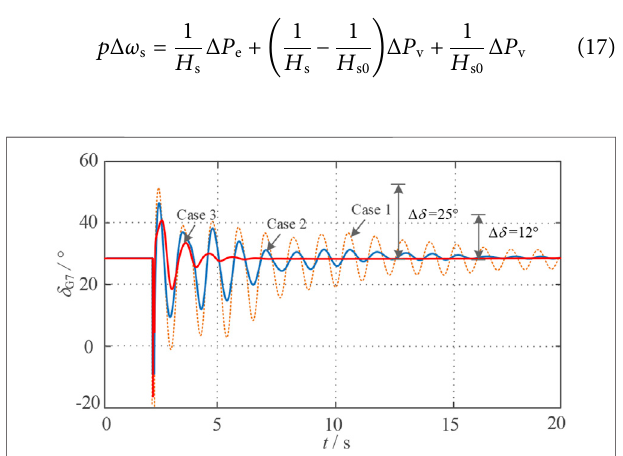
FIGURE 7 | Dynamic responses of G 7 after short circuit